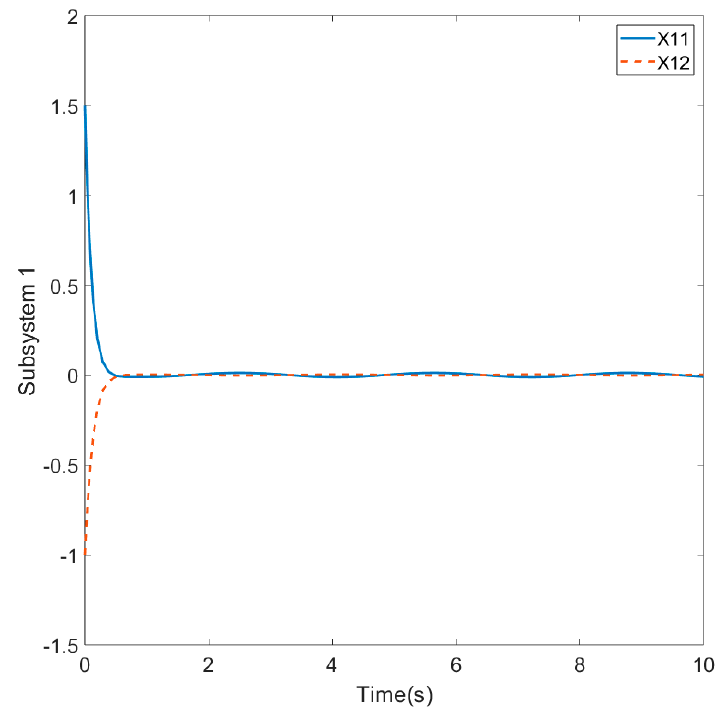
Figure 4. Responses of x 1 for Example 1.